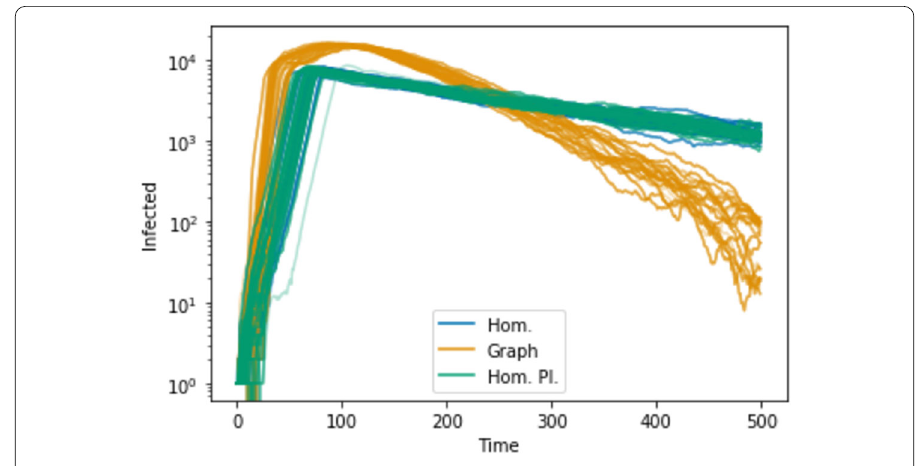
Figure 21 The number if infectious people each day for a social graph and a homogeneous population is compared